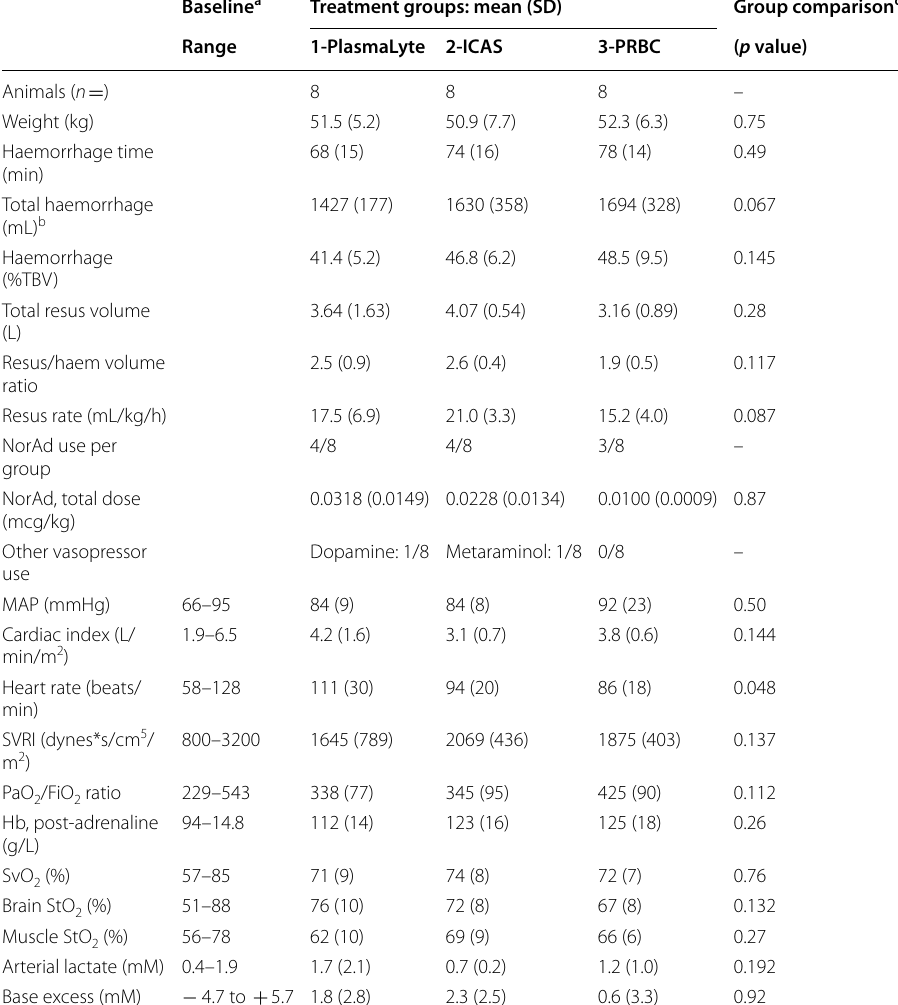
Table 1 Baseline characteristics and treatment variables, and baseline primary outcome